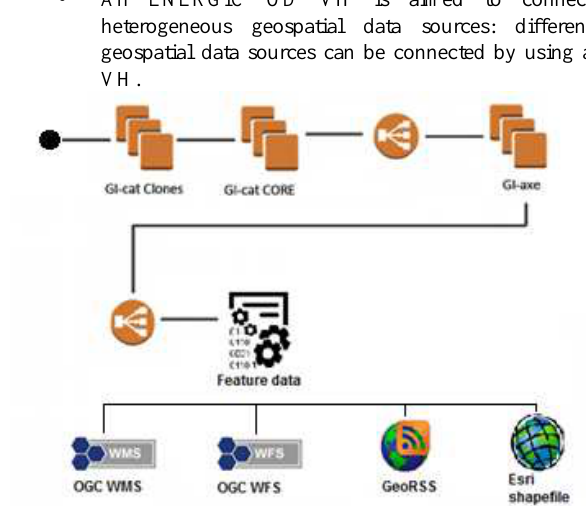
Figure 2. Architecture of the Virtual